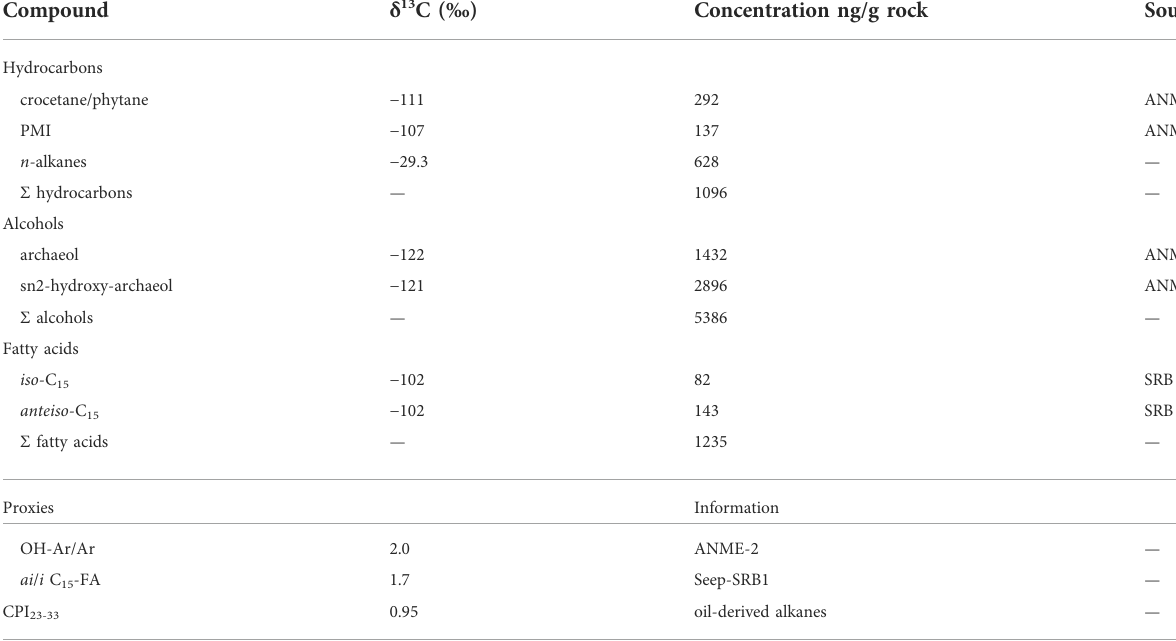
TABLE 2 Results from lipid biomarker analysis of methane-derived carbonate